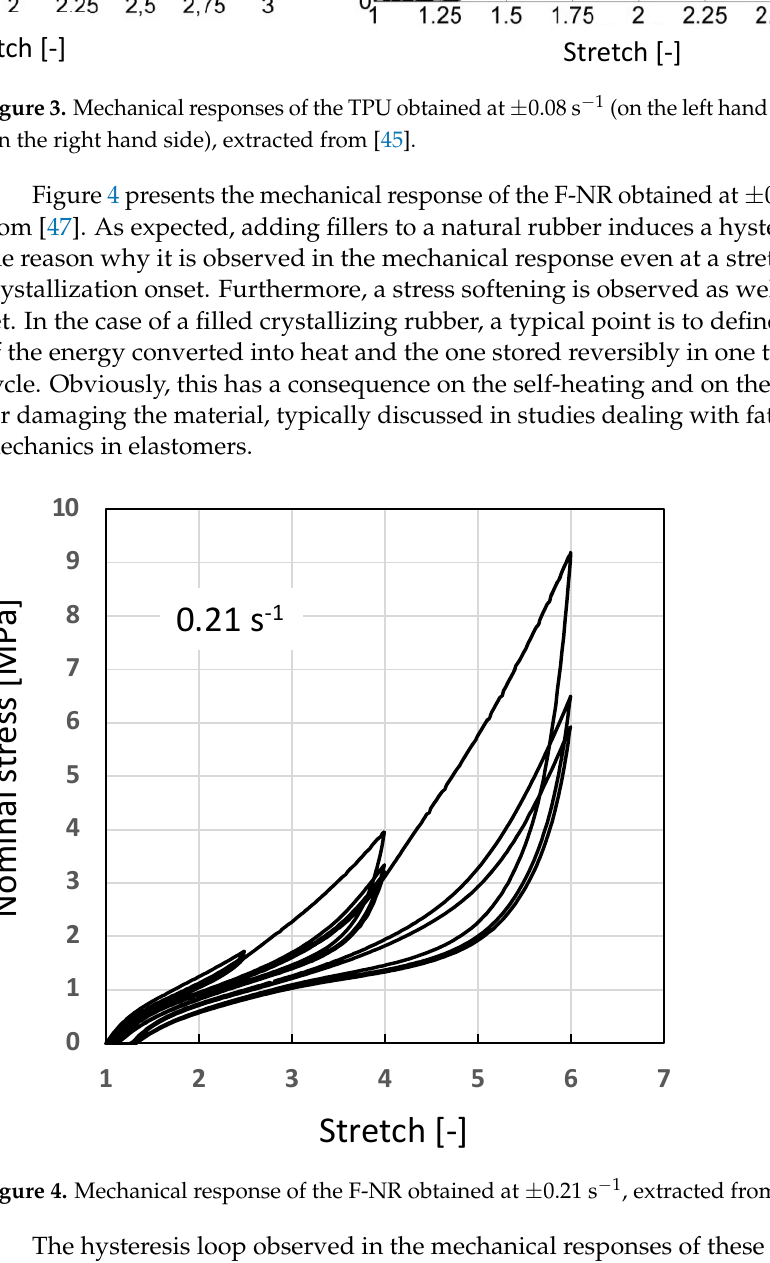
Figure 4. Mechanical response of the F-NR obtained at